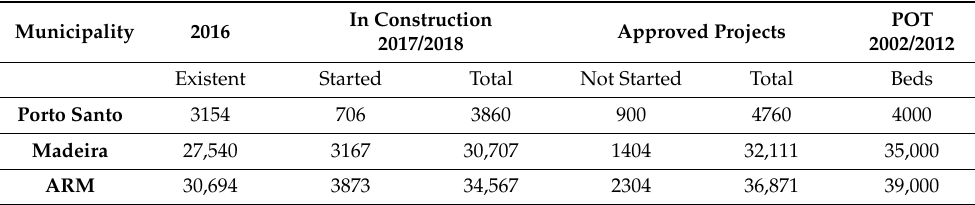
Table 5. Tourism development projects in ARM. (Source: Edited by